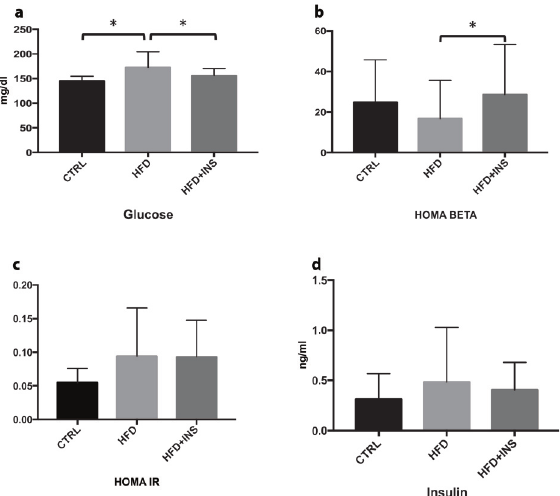
Figure 2 - ( a ) Fasting glucose, CTRL (Control group-regular chow), HFD (rich in fat and low carbohydrates chow) and HFD+INS (plus oral insulin gavage). Values are mean ±SD. *p<0,05 CTRL versus HFD and HFD versus HFD+INS. ( b ) HOMA BETA index, *p<0,05 HFD versus HFD+INS. ( c ) HOMA IR index. ( d ) Insulin fasting levels.